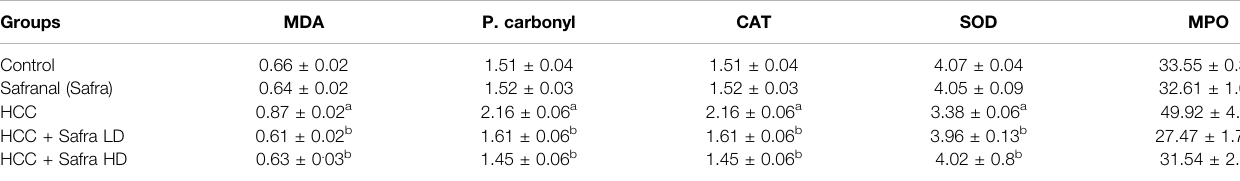
Valuesareexpressedasmean±SEMofsixratspergroup.Concentrationisexpressedasnmol/mgproteinforMDA,P.carbonylactivityisexpressedasunit/mgproteinforCAT,andSOD activity is expressed as m unit/mg protein for MPO. Signi fi cance was determined by one-way ANOVA followed by Dunnett ’ s t test: a p < 0.05 vs. normal group. b p < 0.05 vs.